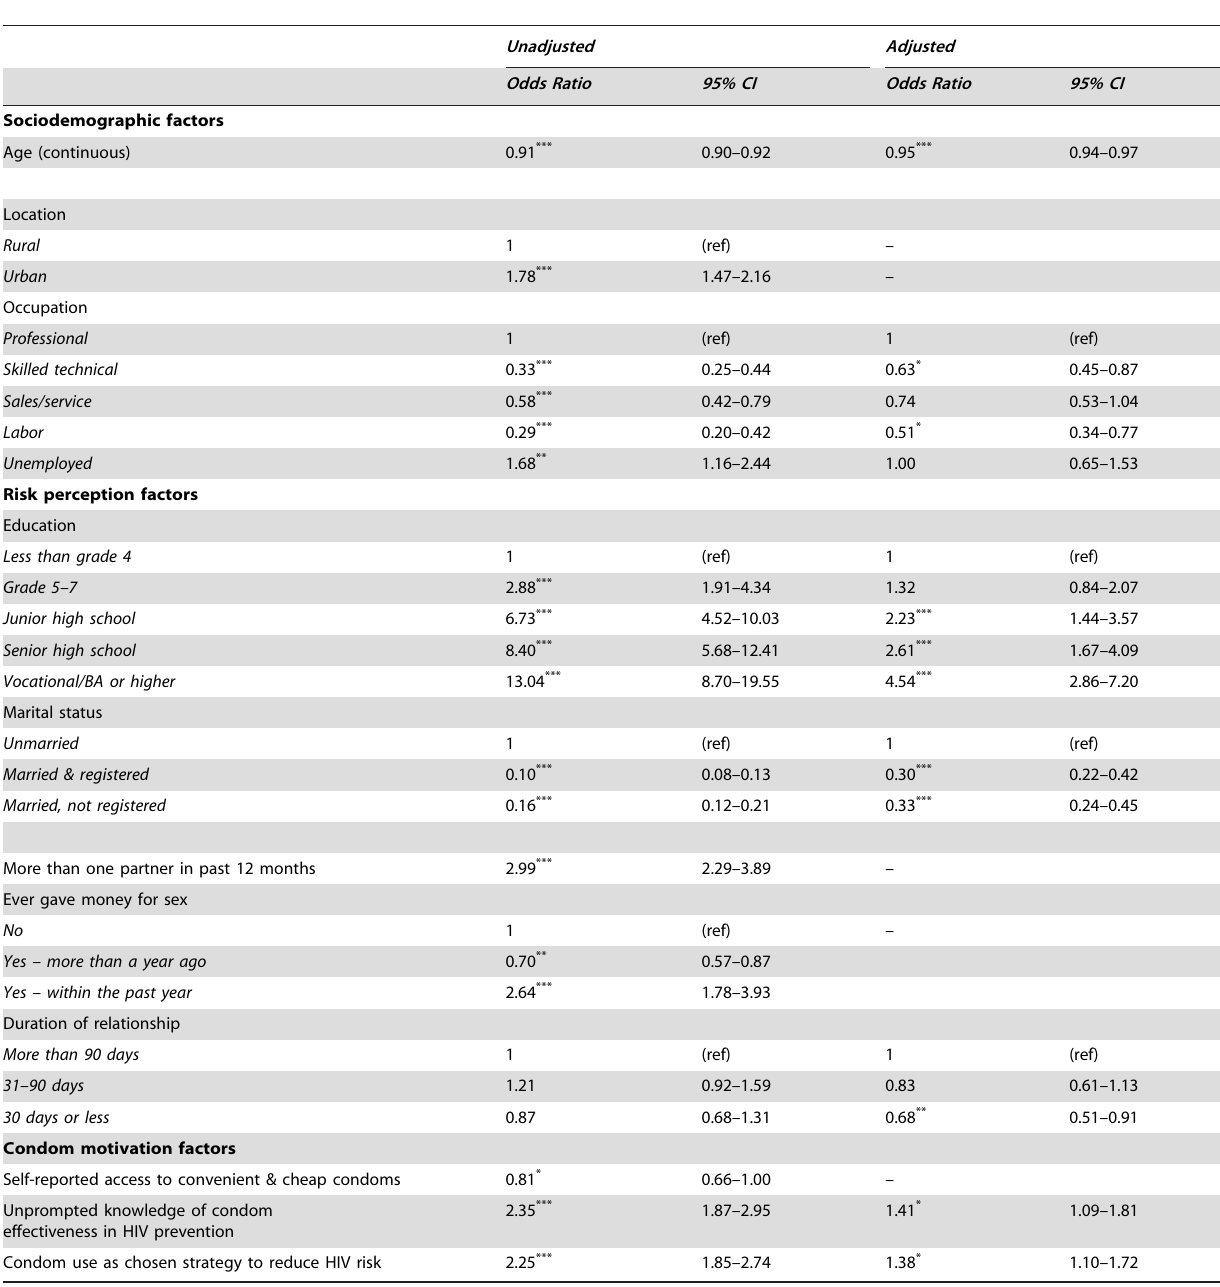
Table 2. Unadjusted and adjusted odds ratios of reporting greater condom use (never, sometimes/half, mostly/always) among men with regular partners